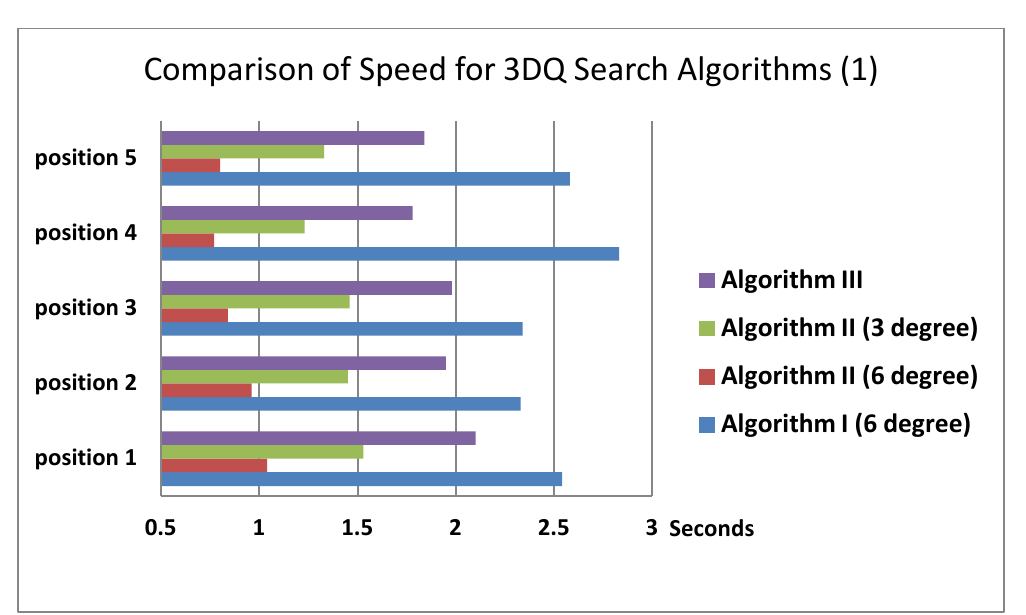
Figure 11. Comparisons of query speed for different search algorithms at five positions on a small 3D solid and large 2D polygon datasets of Dublin